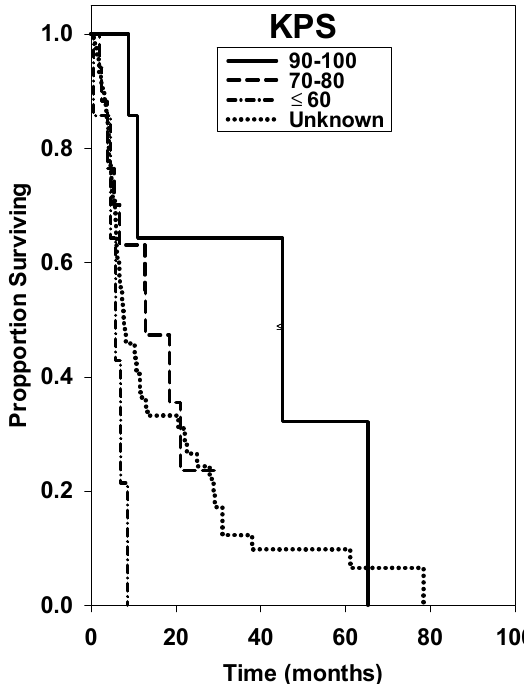
Figure 1. Overall survival (OS) curves of patients with ages <65, 65+, or unknown at time of brain metastasis diagnosis.